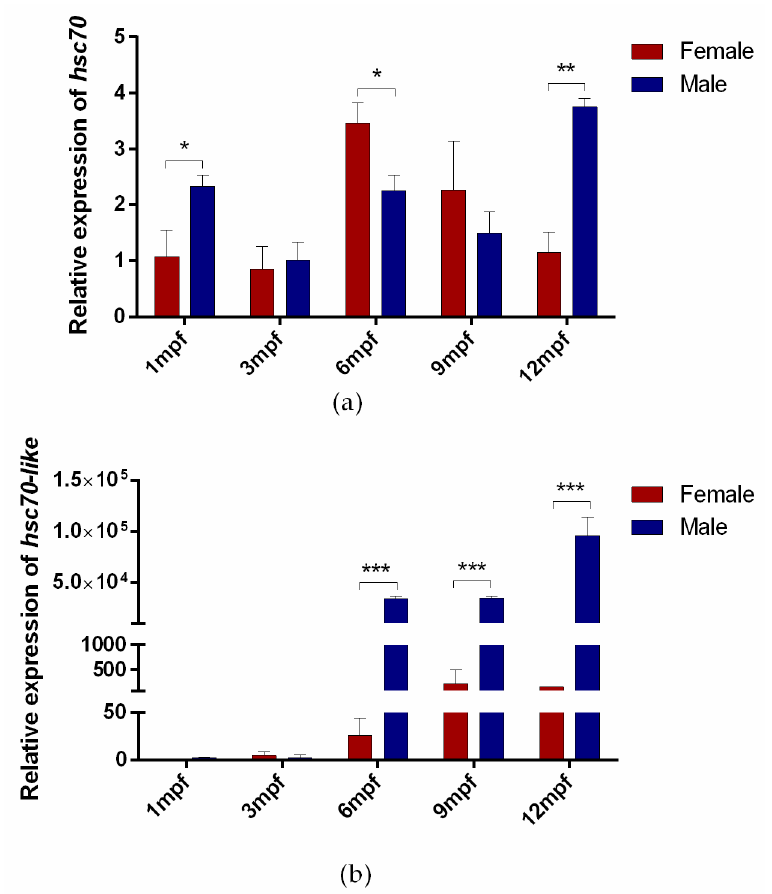
Figure 5. Expression of hsc70 and hsc70-like genes in the gonads of male and female C. semilaevis at different stages. ( a ) Expression of hsc70 during male and female gonadal development; ( b ) Relative gene expression of hsc70-like during male and female gonadal development. Relative mRNA levels were shown as the means ± SEM ( n = 3), and values were normalized using β -actin as the internal control. * p <0.05; ** p < 0.01; *** p < 0.001. mpf, months post fertilization.